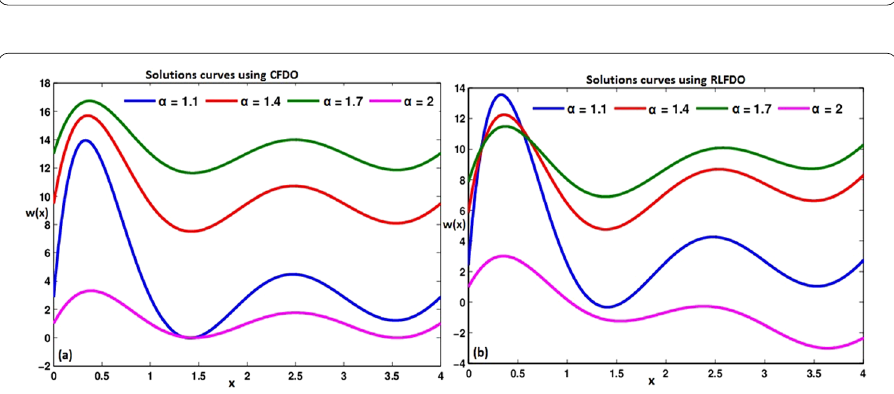
Figure 3 Steady-state solutions curve varies x using ( a ) CFDO and ( b ) RLFDO of Example 5.2